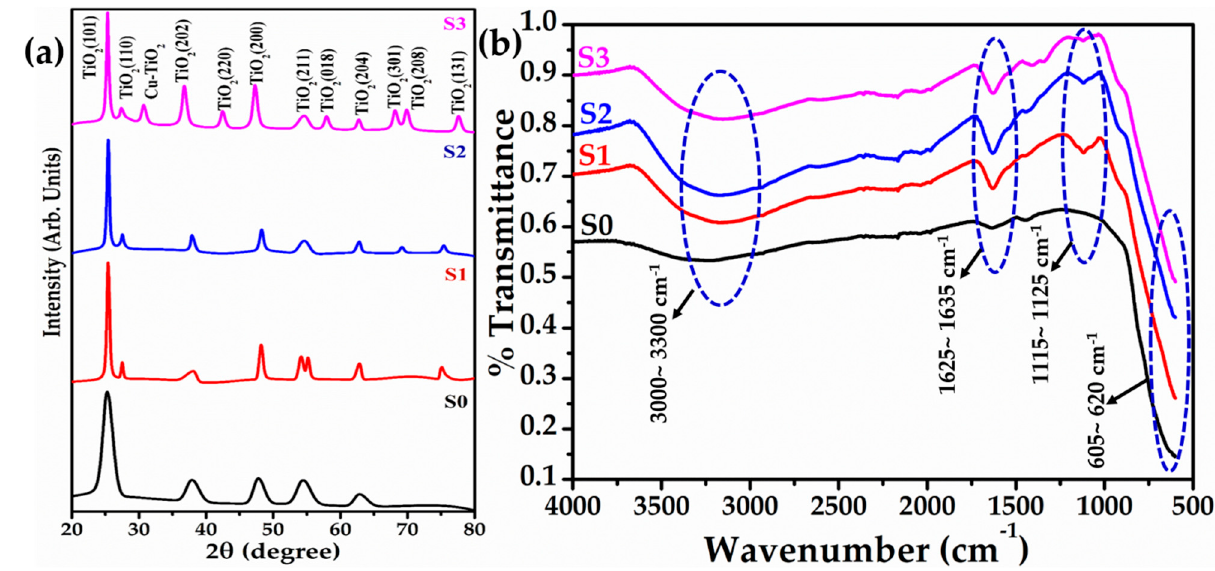
Figure 1. Typical ( a ) XRD pattern, and ( b ) FTIR spectra of pure and Cu-doped TiO 2 nanomaterials. The optical properties of the synthesized pure and Cu-doped TiO 2 nanomaterials The chemical bonding, functional properties and chemical compositions of the pre- were examined by UV-visible spectroscopy. Figure 2a depicts the typical UV–vis spectra pared pure and Cu-doped TiO 2 nanomaterials were examined by Fourier transform infrared of the prepared materials. The absorption peak for pristine TiO 2 (S0) is observed at 268.5 (FTIR) spectroscopy. Figure 1b depicts the typical FTIR spectra of pure and Cu-doped nm, whereas Cu doping caused red shift of 2–8 nm with maximum for S1 sample. Figure TiO 2 nanomaterials which exhibited several well-defined peaks. For all the samples, the 2b demonstrates the Tauc’s plot for the synthesized materials. The calculated bandgap observed FTIR spectra exhibited a small absorption band in the range of 1625–1635 cm − 1 values for the prepared materials are 3.92 eV, 3.33 eV, 3.76 eV, and 3.86 eV for S0, S1, S2, along with a broad band in the range of 3000~3300 cm − 1 which are assigned to the O–H bending and stretching modes of water, respectively [30–32,46]. The presence of a defined and S3, respectively. Interestingly, the sample S1 with doping concentration of 13 × 10 17 peak in the range of 1115–1125 cm − 1 , for all samples, can be correlated to the C-O stretching atoms/cm 3 exhibits lowest bandgap of 3.33 eV and provides maximum density of states. vibrations [32]. All the samples exhibited a broad peak in the range of 605~620 cm − 1 , a well-known finger print region for metal-oxygen (M-O; Ti-O)-related peak which clearly revealed that the synthesized materials are metal oxides